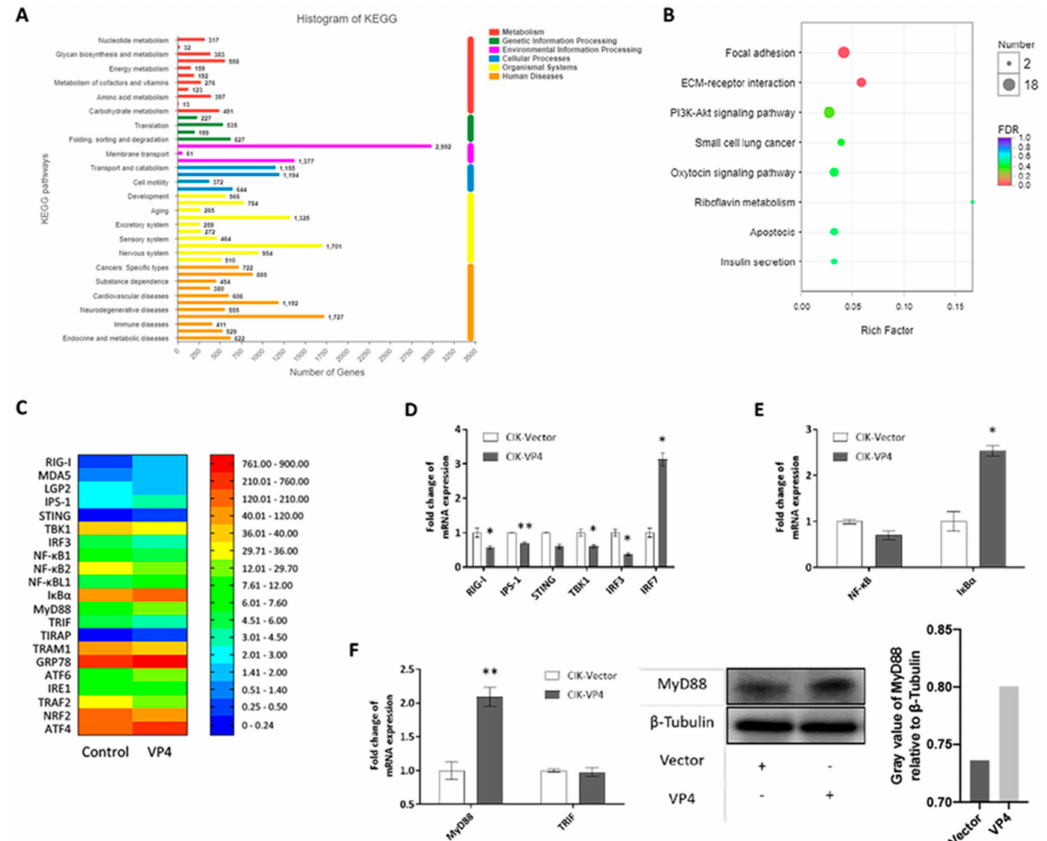
Figure 5. Transcriptome analysis of VP4 overexpressed in CIK cells. ( A ) Functional annotation of sequences based on Kyoto Encyclopedia of Genes and Genomes (KEGG) categorization. The Y -axis indicates the category, the X -axis the number of transcripts in a category. ( B ) Bubble chart of functional annotation of 4-fold di ff erentially expressed genes based on KEGG categorization. The Y -axis indicates the signaling pathway category, the X -axis the enrichment factor. ( C ) Heat map of focused genes raw expression in transcriptome database. ( D – F ) Verification of gene expressions. Transcriptome sample CIK cells which were stably expressed with empty vector (CIK-vector) of VP4 (CIK-VP4) were seeded into 12-well plates for 24 h and examined for RLR related genes ( D ), NF- κ B related genes ( E ) and TLR related genes ( F ) left). ( F ) right) VP4 promotes MyD88 production. CIK cells transiently transfected with VP4 / empty vector were seeded in 6-well plates. Twenty-four hours later, cell lysate was used for WB analysis using MyD88 polyclonal antiserum and β -Tubulin as control. All the experiments independently were repeated at least three times. The histogram on the right exhibits the relative protein expression levels, which were quantified using ImageJ software. Data of qPCR are shown as mean ± SD of 4 wells of cell per group and are from one experiment representative of three independent experiments. Significance was calculated in relation to the control group. * p < 0.05, ** p < 0.01 (two tailed Student’s tests). The relative transcription levels were normalized to the transcription level of EF1 α gene and are represented as fold induction relative to the transcription level in control cells, which was set to